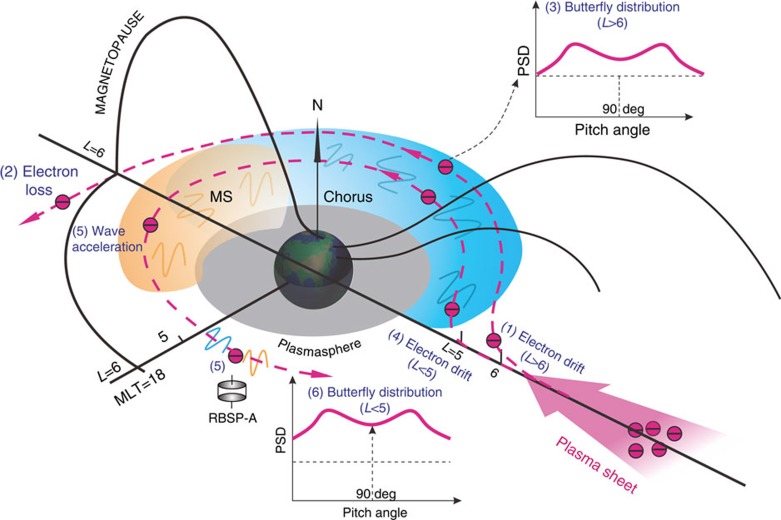
Schematic diagram of formation of butterfly distributions.The long black curves indicate Earth's magnetic field lines. The grey area denote the region of dense cold plasma known as plasmasphere. The blue and yellow areas stand for primary occurrences of chorus and MS waves. The wavy line represents chorus (blue) and MS (yellow) waves. Relativistic electrons originating from the plasma sheet azimuthally drift eastward around Earth. (1) Higher pitch angle electrons at L>6 drift to larger radial distance beyond the dayside magnetopause and are consequently lost due to the day–night magnetic field asymmetry (2), yielding the regular butterfly distribution (3). (4) Electrons at L<5 drift inside the magnetosphere without loss to the dayside magnetopause because of a very small day–night magnetic field asymmetry, continuously resonating with chorus and MS waves. (5) Wave acceleration can enhance electron PSD primarily within the medium pitch angles, leading to the formation of the unusual butterfly distribution (6).